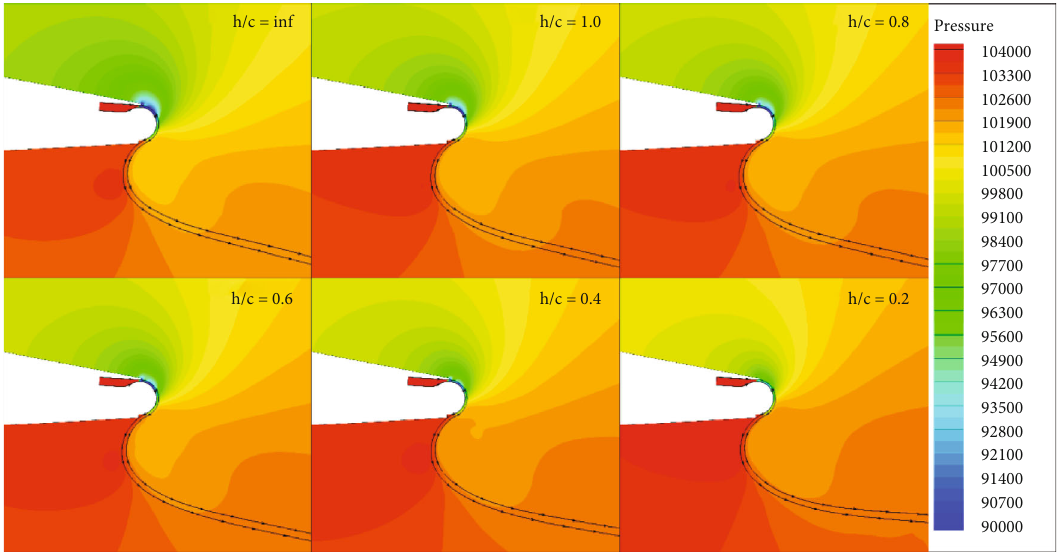
Figure 30: Pressure contours for α = 4 ° , NPR = 1 : 25 at various ride heights.